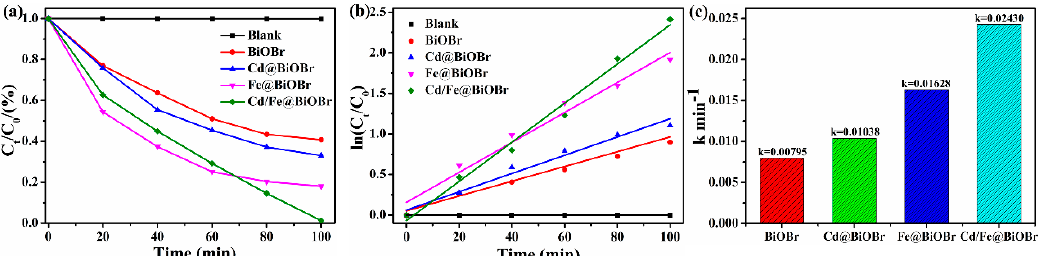
Figure 5. Variation of Rhodamine B (RhB) concentration ( C t / C 0 ) against photodegradation time for samples ( a ); pseudo- first-order kinetics for the degradation of RhB with BiOBr, Bi 1 − x Cd x OBr, Bi 1 − x Fe x OBr and Bi 1 − x − y Cd x Fe y OBr under visible light irradiation ( b ); ln( C 0 / C t ) and irradiation time of samples ( c ).